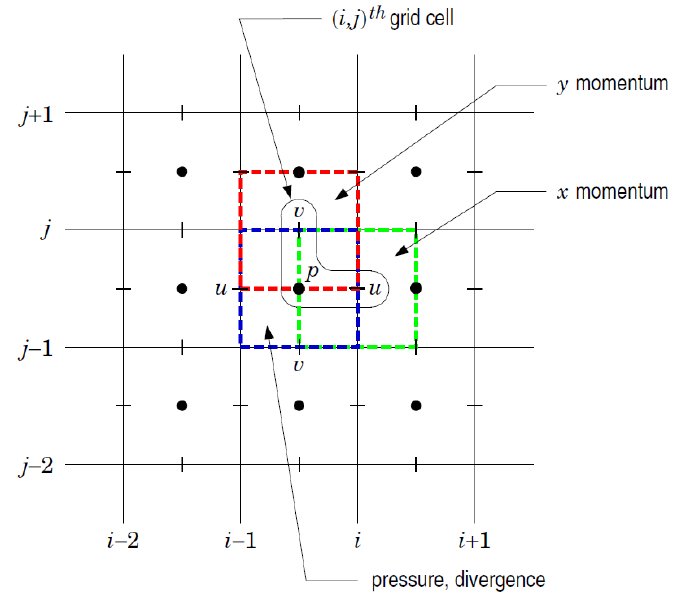
Figure 2. Illustration of a staggered grid in 2-D